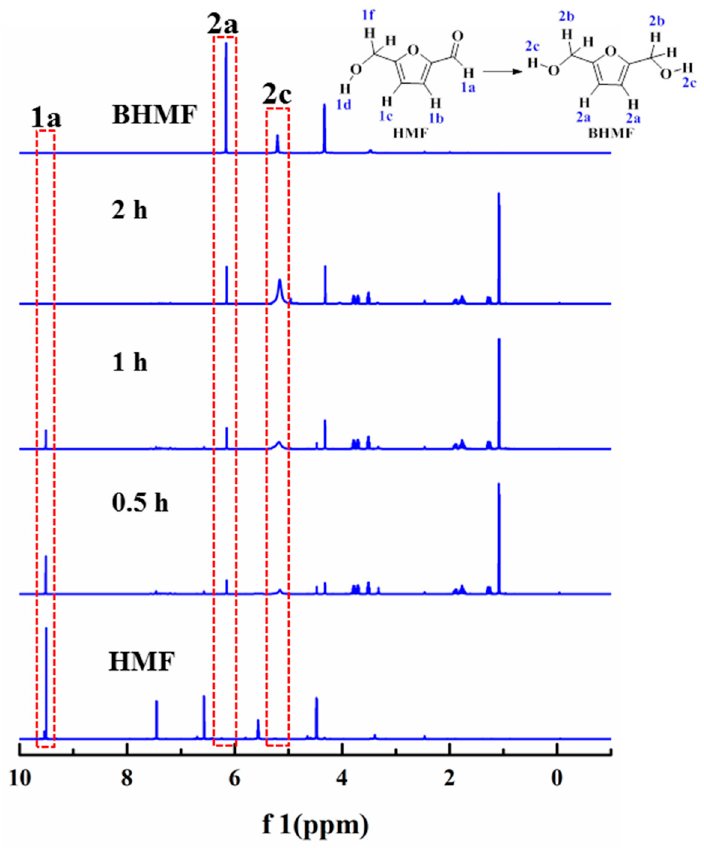
Figure 6. Ex situ 1 H NMR spectra of hydrogenating HMF to BHMF at 25 °C in 0.5–2 h. (Reaction conditions: HMF (0.5 mmol), Ph 2 SiH 2 (1.4 mmol H − ), K 2 CO 3 (0.1 mmol), and MTHF (2.0 mL); After